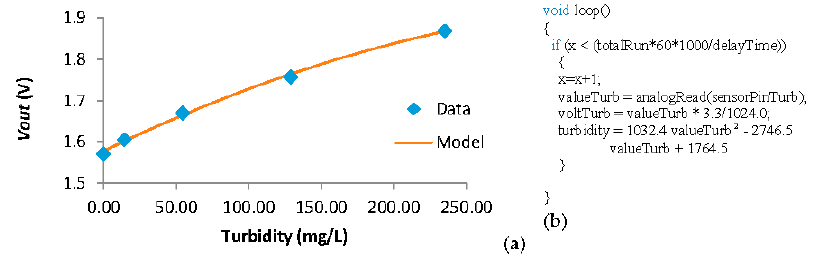
Figure 11. ( a ) Data and ( b ) code of the turbidity sensor.